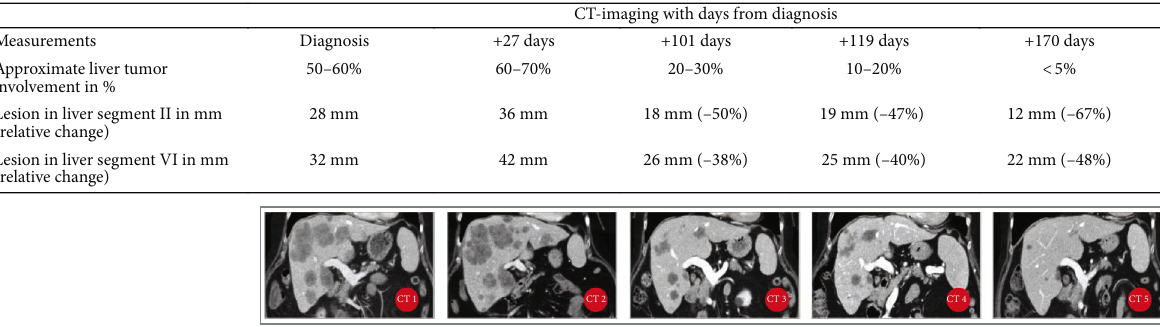
Figure 2: CT-imaging with measurement of lesions in liver segments II and VI and approximate liver tumor involvement. Abbreviations: CT = computerized